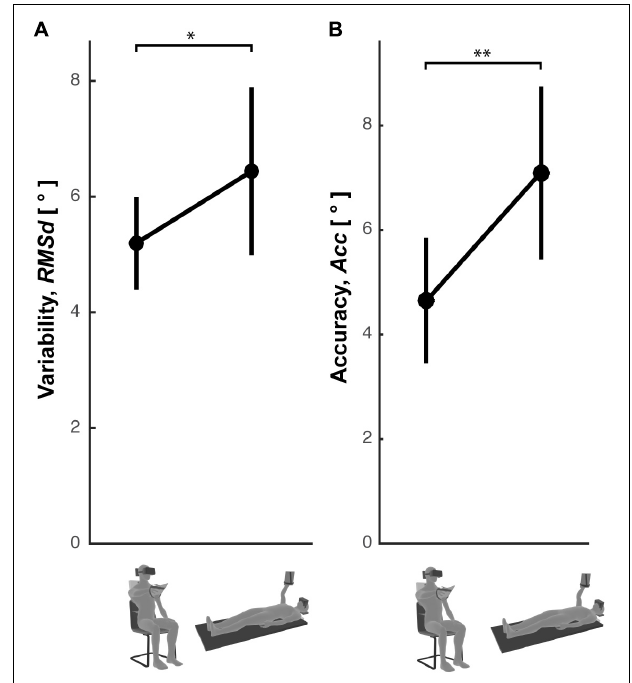
FIGURE 8 | Response errors in the Straight Neck Experiment. Subjects’ response (A) variability and (B) accuracy observed in the Seated and Supine conditions for the cross-modal task without lateral neck flexions. Vertical whiskers correspond to 95% confidence intervals. * and ** represent p < 0.05 and p < 0.01,